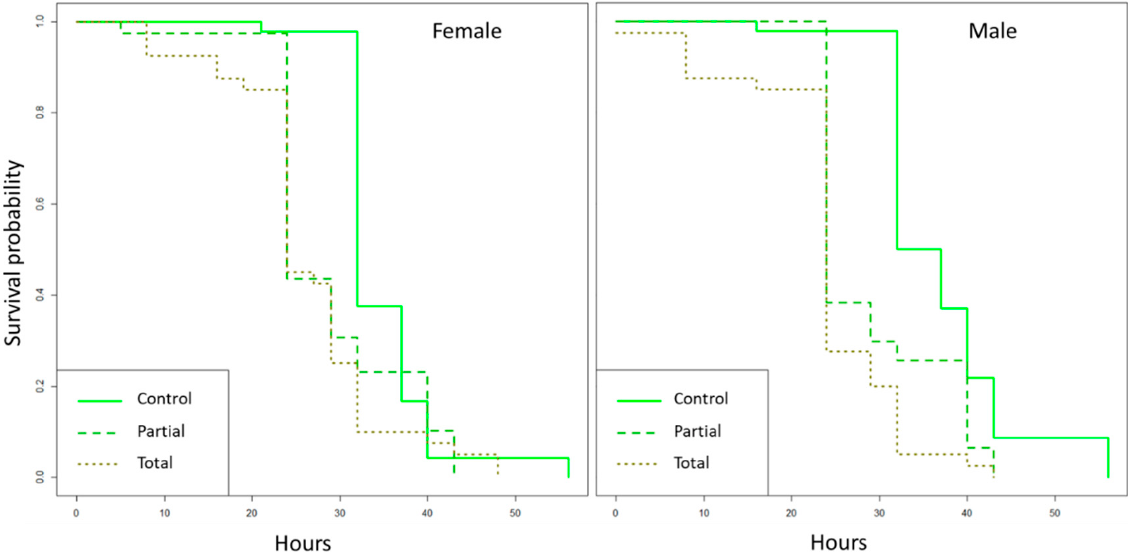
Figure 4. Effect of Enterobacter sp. AA26 on female ( left ) and male ( right ) survival under starvation. Significant differences were measured with a log-rank test. The x-axis represents time in hours.